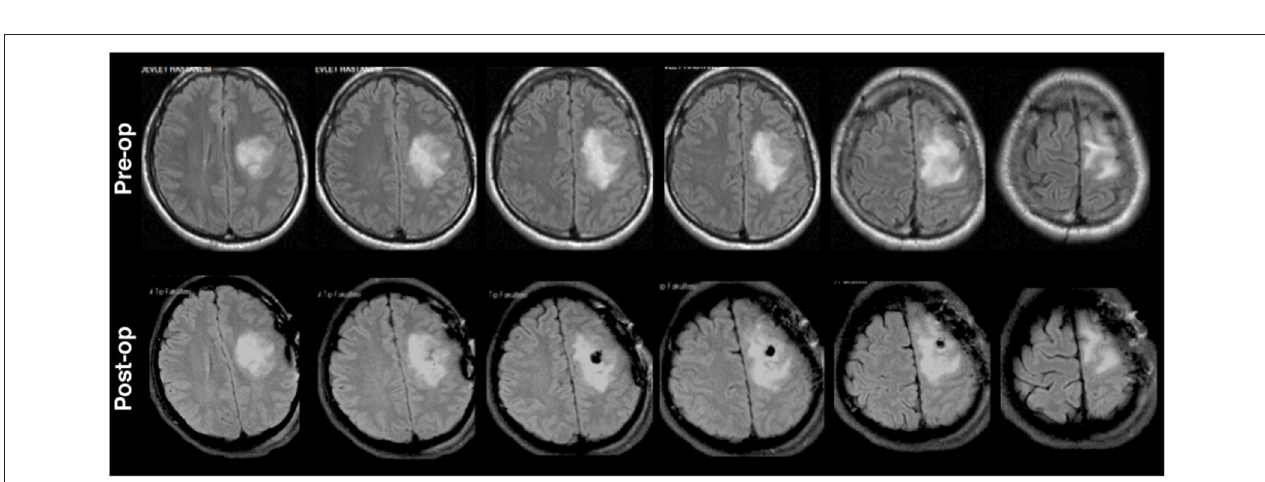
FIGURE 2 | Preoperative (upper) and postoperative (lower) axial MRI FLAIR sequences for P2. Surgery was terminated with incomplete resection due to determination of right hand weakness.